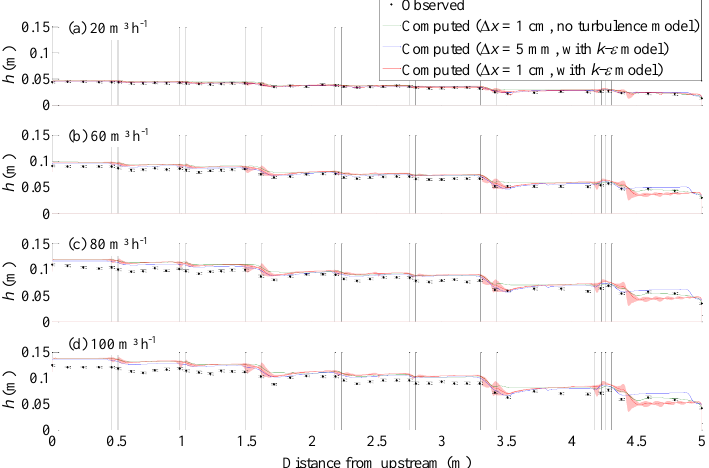
Figure 6. Observed and computed water depths h for inflow discharges varying between 20 and 100 m 3 h − 1 in street 4. The shaded area ( (cid:4) ) represents the range of variation in the crosswise direction of the computed water depths ( (cid:49)x = 1cm, with k − ε model).